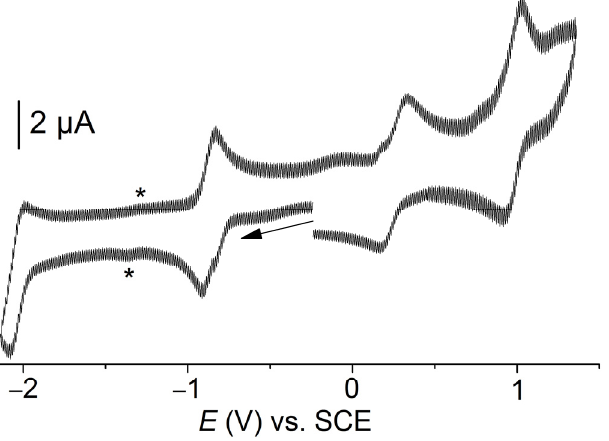
Figure 2. Cyclic voltammogram of [Co(TTMPP)] in 0.1 M n- Bu 4 NBF 4 /DMF under Ar at a scan rate of 100 mV . s ‒ 1 . The * mark a wave which might be due to traces of O 2 .